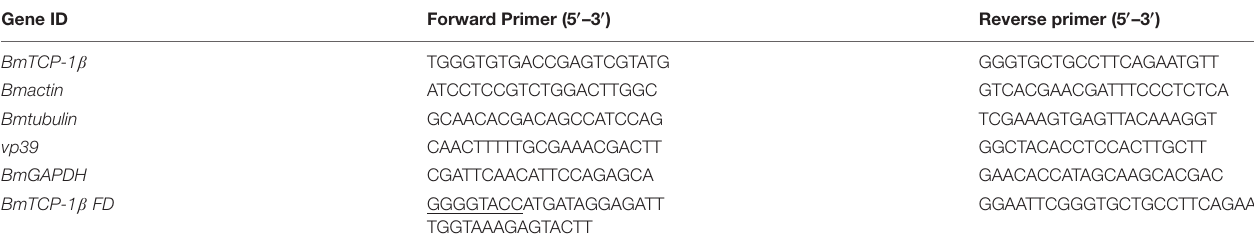
TABLE 1 | Primers used in RT-qPCR.